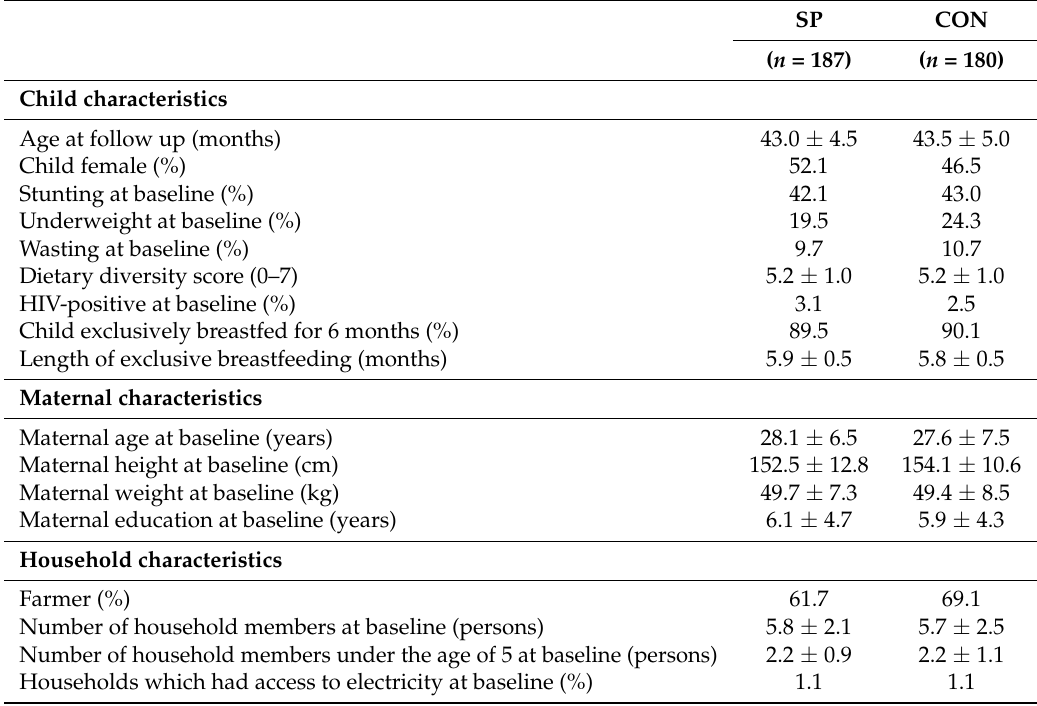
Table 1. Baseline and follow up characteristics of children by intervention